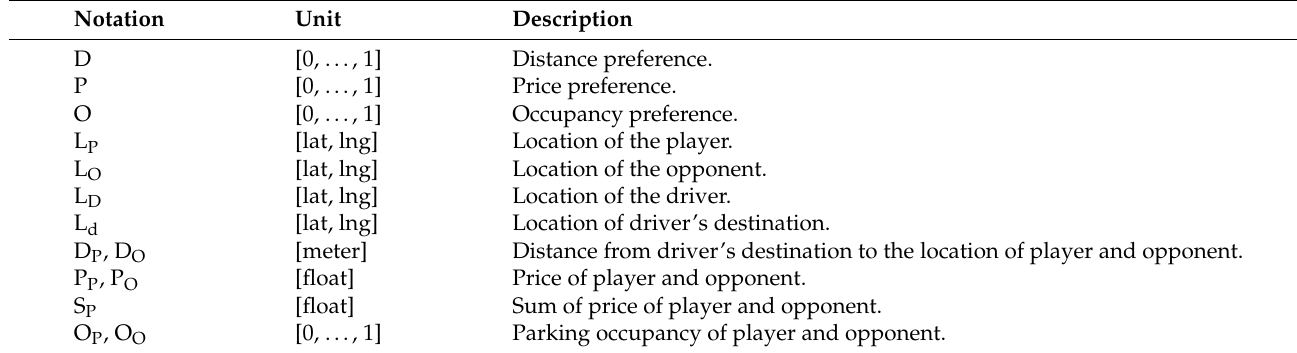
Table 1. Notation used in driver decision making